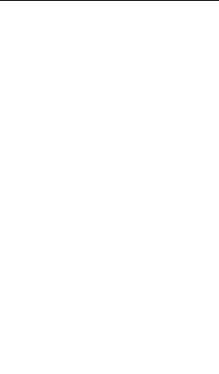
Figure 1. Digital innovation